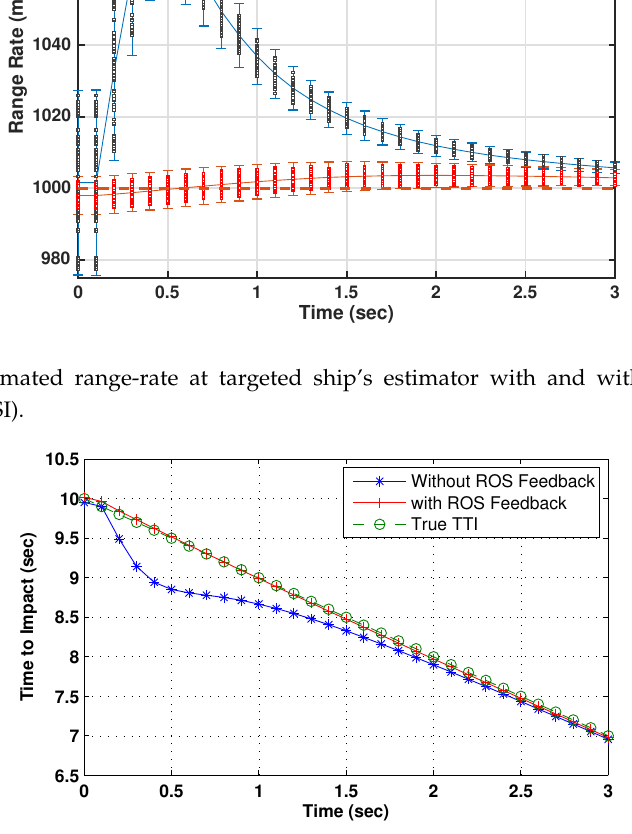
Figure 16. Estimated time to impact at targeted ship’s estimator with and without